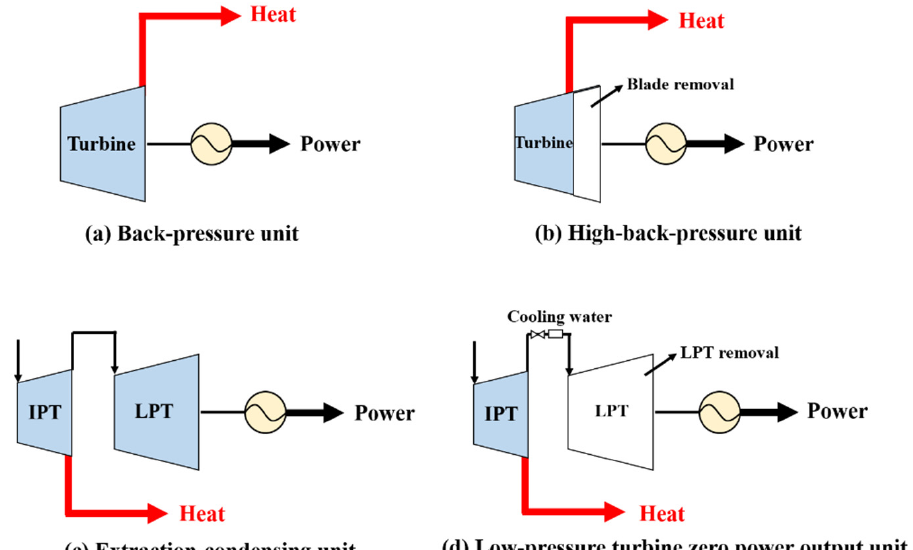
Figure 1. Different types of units .